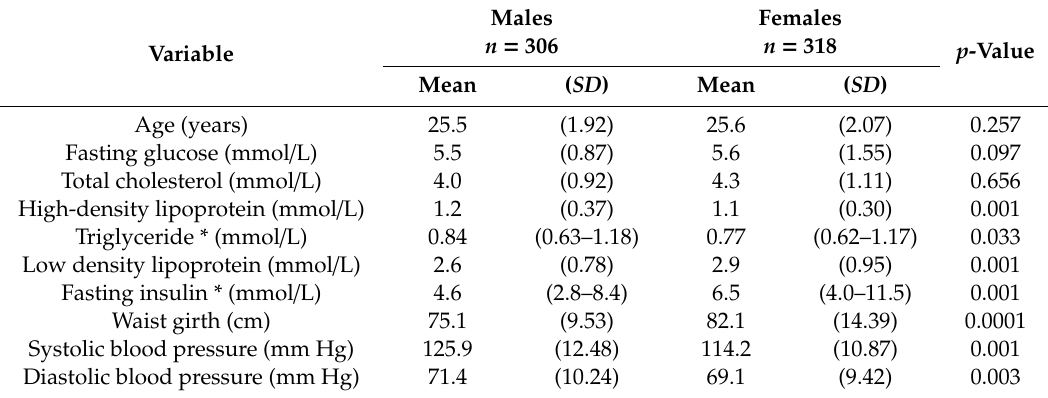
Table 1. Descriptive statistics of metabolic syndrome and the prevalence of binge alcohol consumption amongst Ellisras young adults aged 21 to 31 years.